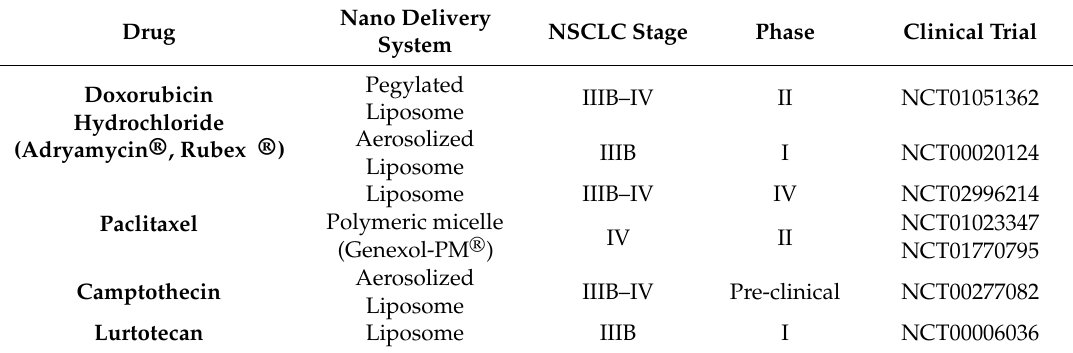
Table 4. Active and completed nanomedicine-based chemotherapeutic drugs clinical